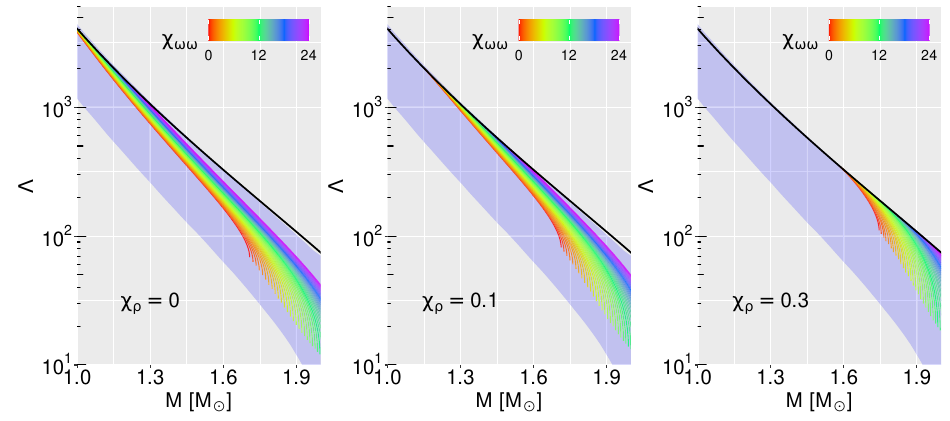
Figure 2. Λ ( M ) diagrams as a function of χ ωω (color scale) for three values of χ ρ : 0 (left), 0.1 (center), and 0.3 (right). The solid black line represents the purely hadronic Λ ( M ) sequence, and the black dotted specifies the maximum mass of each hybrid EoS. The blue band indicates the 90% posterior credible level from the LIGO / Virgo analysis for the GW170817 event